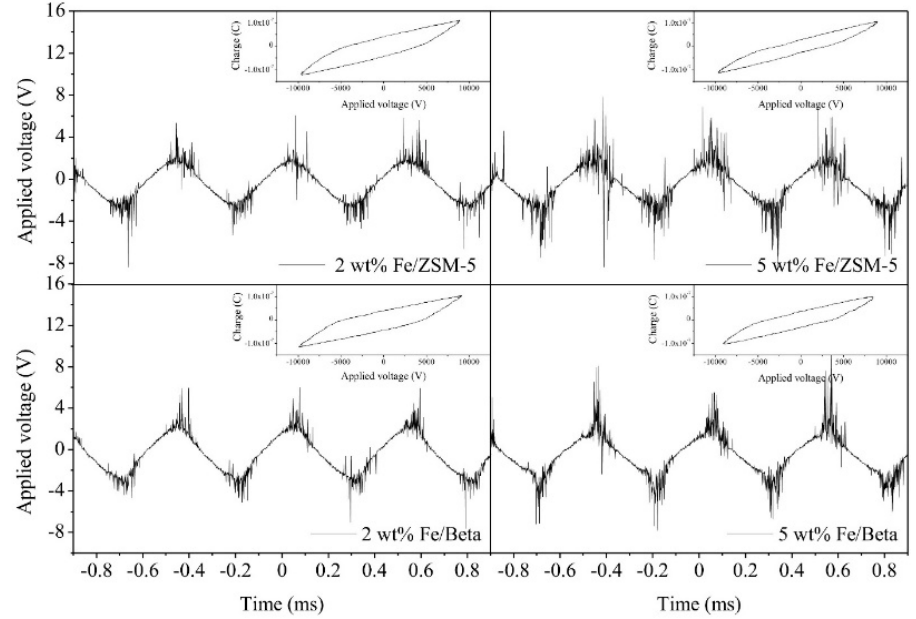
Figure 16. Discharge properties (current pattern and Lissajous plot) of Fe/ZSM-5 and Fe/Beta in toluene oxidation using a dielectric barrier discharge (DBD) plasma–catalyst hybrid system. Reprinted from Reference [117], with permission from Elsevier.